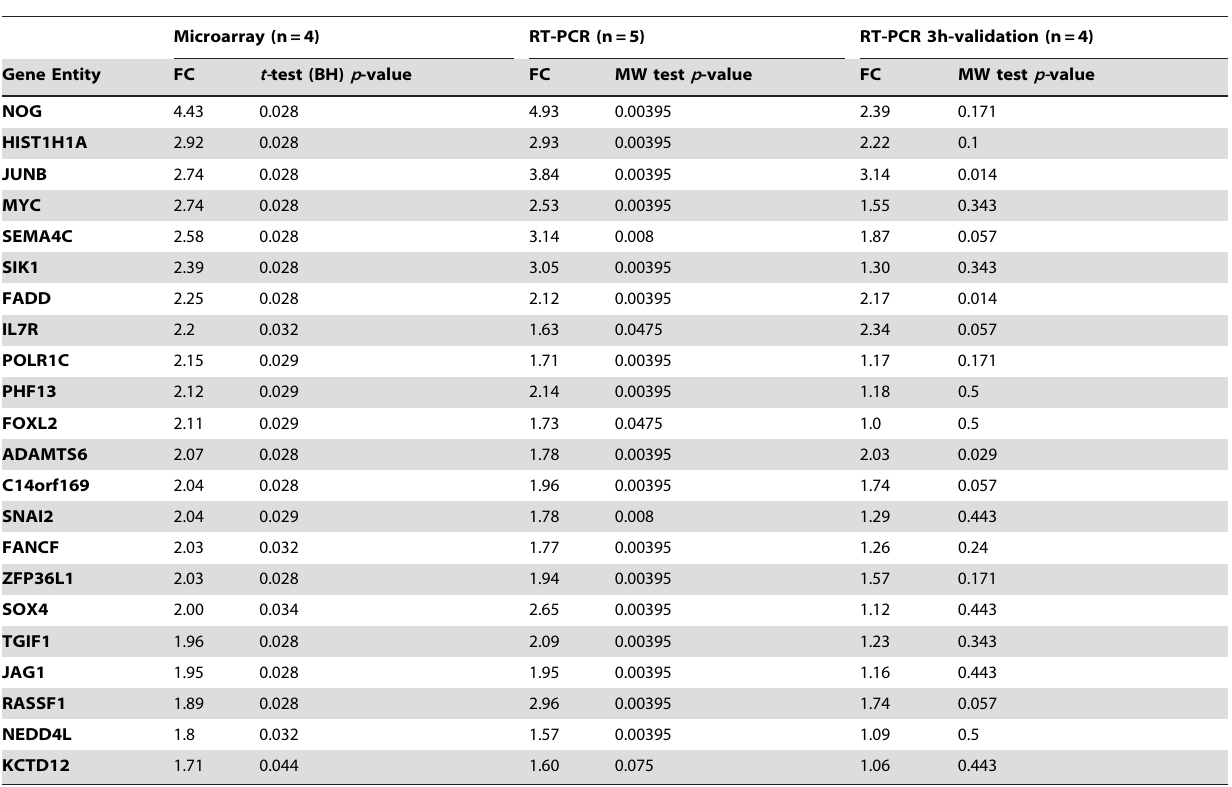
List of genes determined as differentially expressed between Expo and HSC. The table includes the fold change (FC) and the p -value from microarray experiments, first and second RT-PCR validations (duplication of the exposure, after 3 hours of exposure, IPD=20 mW/cm 2 ). BH: Benjamini and Hochberg correction for multiple